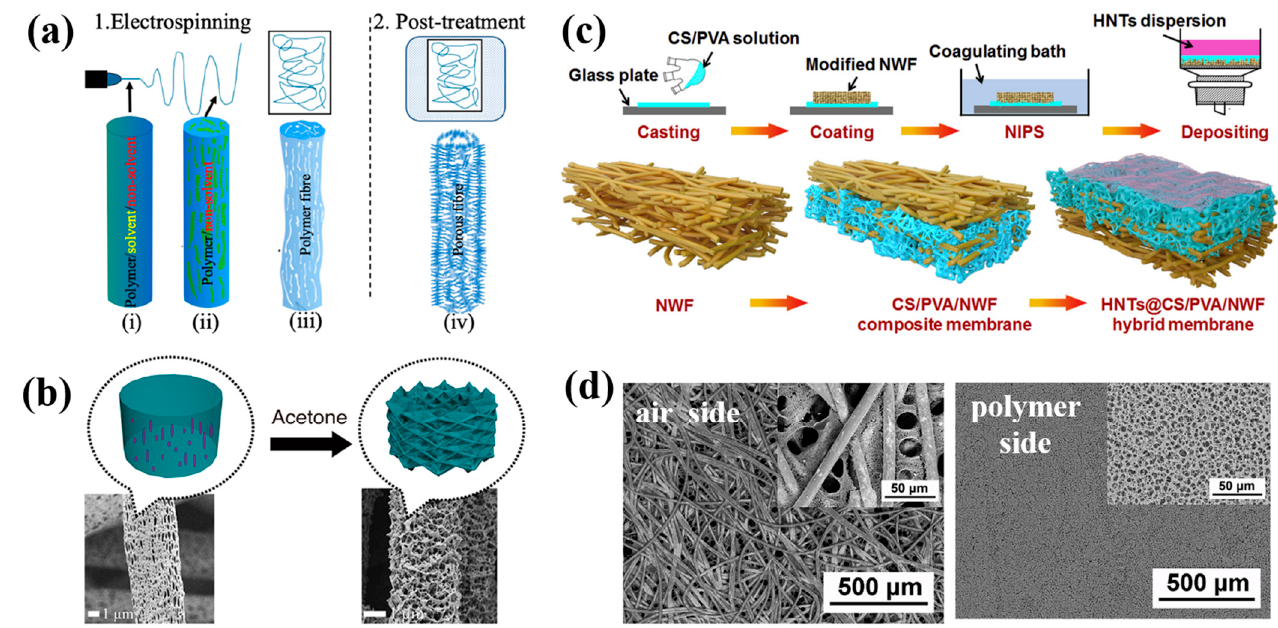
Figure 4. ( a ) Schematic diagram of the preparation of porous PLLA nanofibers; ( b ) SEM photos of nanofibers before and after acetone post-treatment. Reprinted with permission from Ref. [69], Copyright 2019, American Chemical Society. ( c ) Schematic illustration of the fabrication of HNTs@CS/PVA/NWF nanofibers; ( d ) SEM photos of CS/PVA/NWF air filtration membranes. Reprinted with permission from Ref. [131], Copyright 2020, Elsevier.